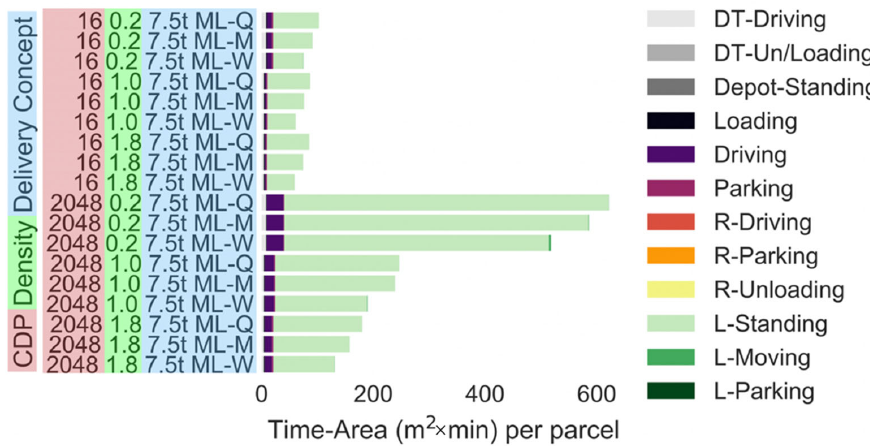
Figure 8. Time-area requirements of modular lockers (number of CDPs: 16 or 2048). Parcel demand level: 0.2: 20% of the current demand, 1.0: current demand, 1.8: 80% increase in the demand. (Note: All parts apart from driving and L-Standing are negligibly small).